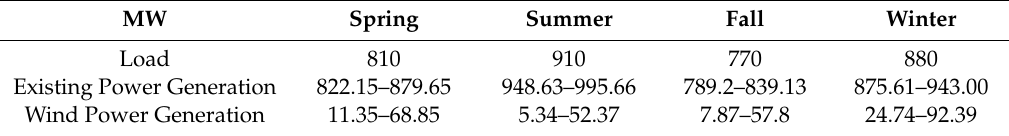
Table 10. Probabilistic scenarios for security limit analysis of the Jeju power grid.